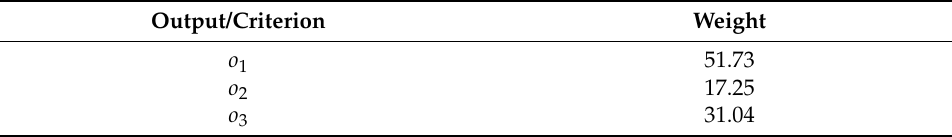
Table 9. Output weights for z = 3.